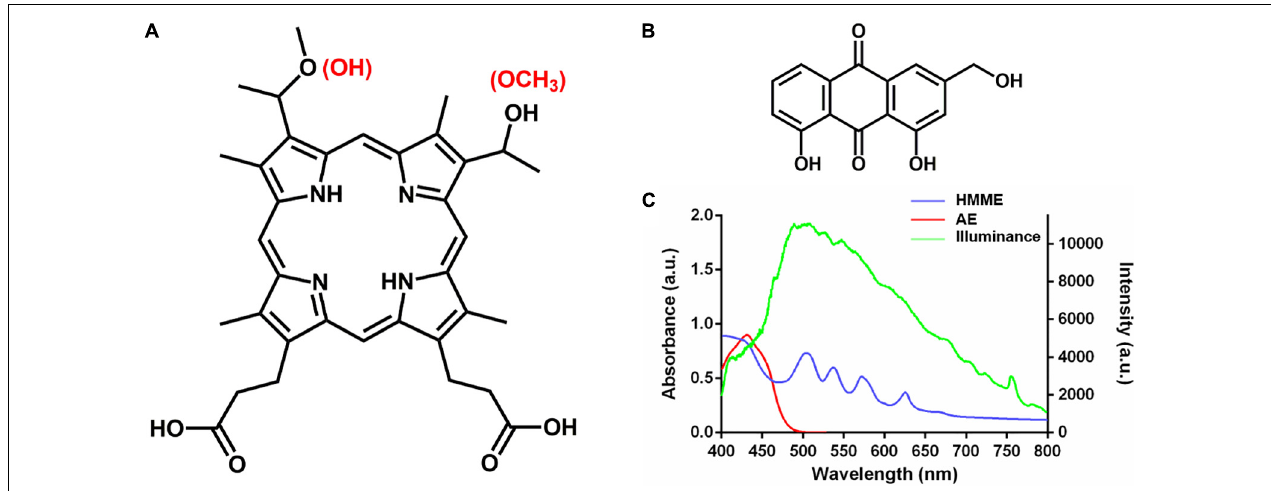
FIGURE 1 | Chemical structure and absorption spectrum of HMME and AE. (A) Chemical structure of HMME; (B) chemical structure of AE; and (C) the absorption spectrum of HMME and AE and the spectrum of light